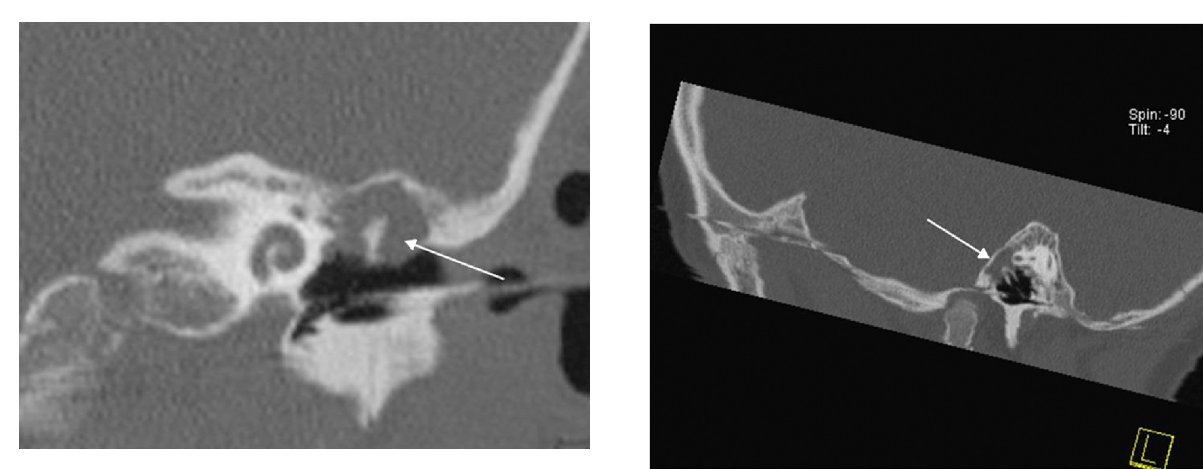
Multidetector computed tomography (MDCT) scan of the temporal bone confirmed that there was no sign of dis- ease recurrence on the right side. On the left side, a mass in the epitympanum suspicious of cholesteatoma was discovered (Figs. 1---4). Surgery confirmed the diagnosis,